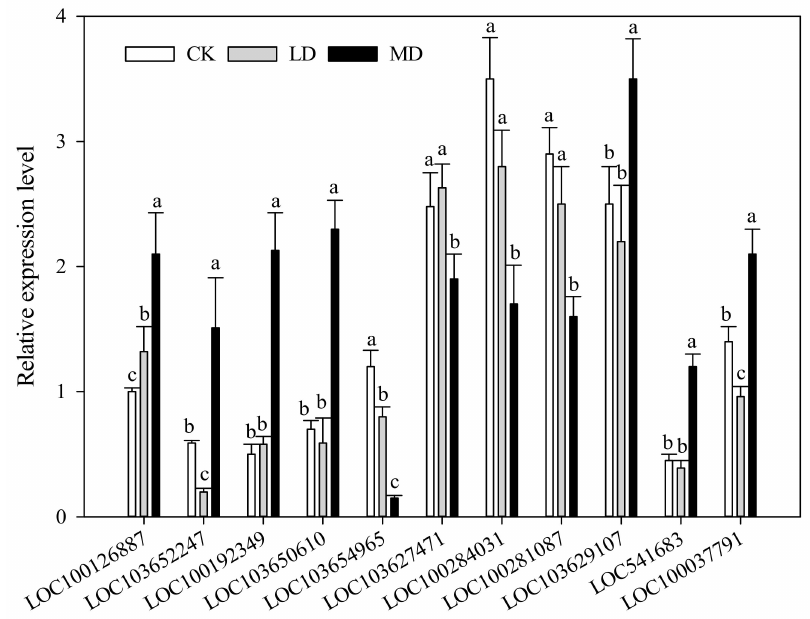
Figure 4. The expression patterns of eleven genes in female panicle tissues under well-watered (CK), light drought (LD), and moderate drought (MD) conditions by qRT-PCR. Values are the mean ± SD of three independent experiments. Maize β -actin expression was used as a